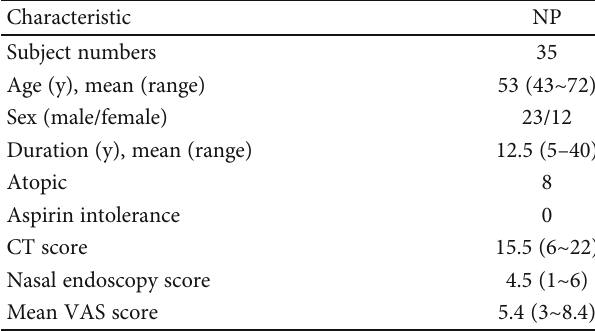
Table 1: Subjects ’